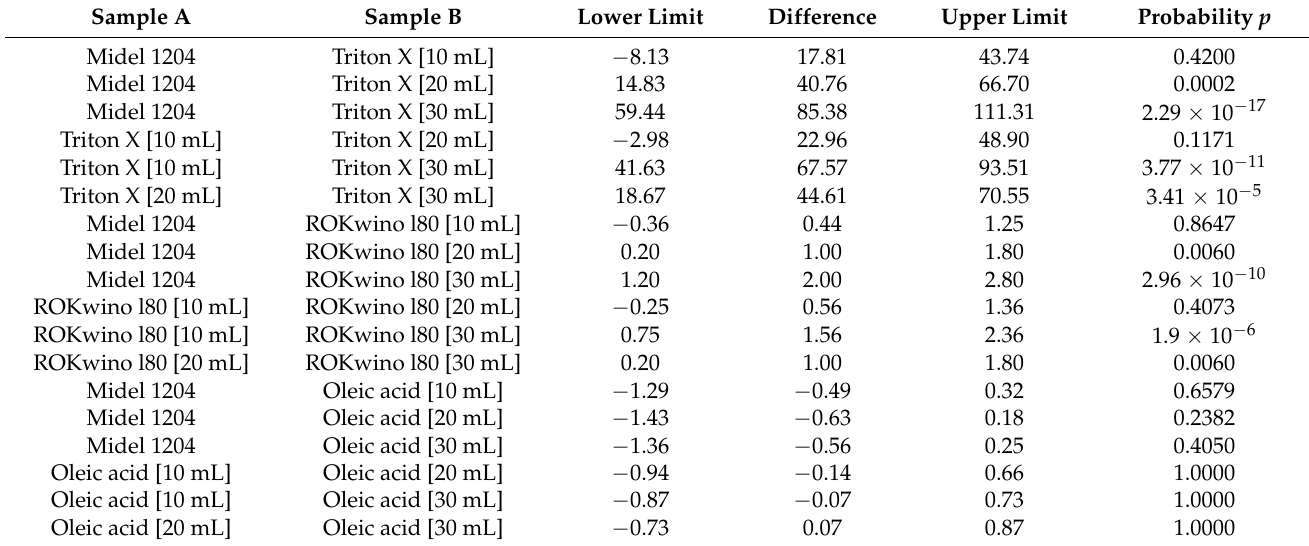
Table 15. Multiple comparison results of the Friedman test between all samples.